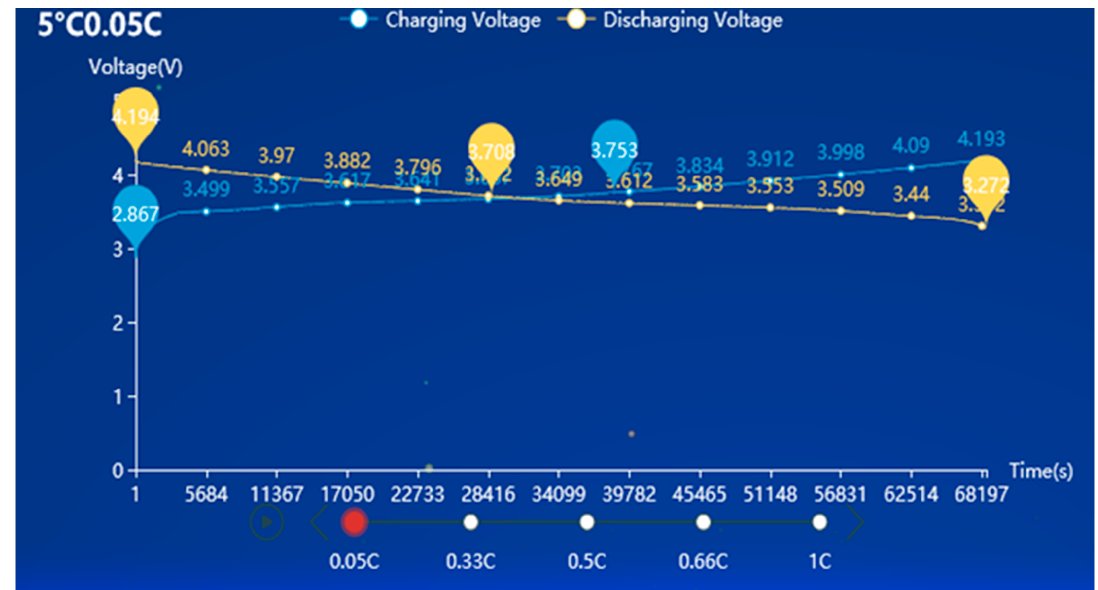
Figure 4. Example of carousel line charts of charge and discharge curves.